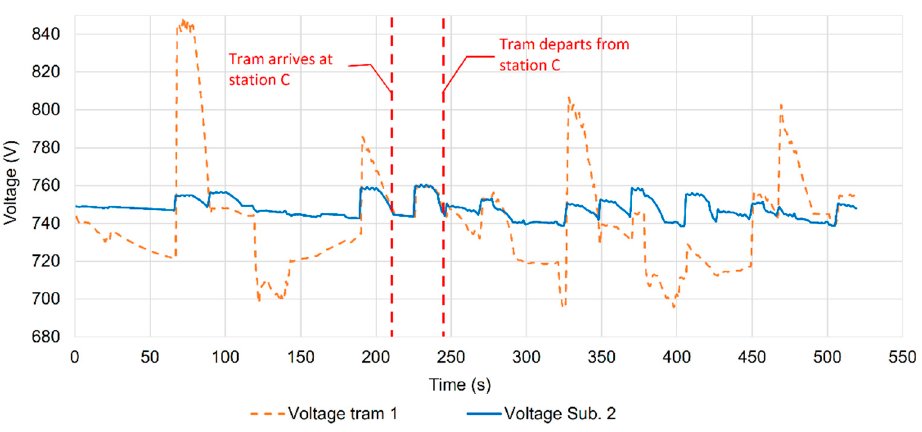
Figure 5. Simulation results (voltage tram 1 and voltage substation 2).